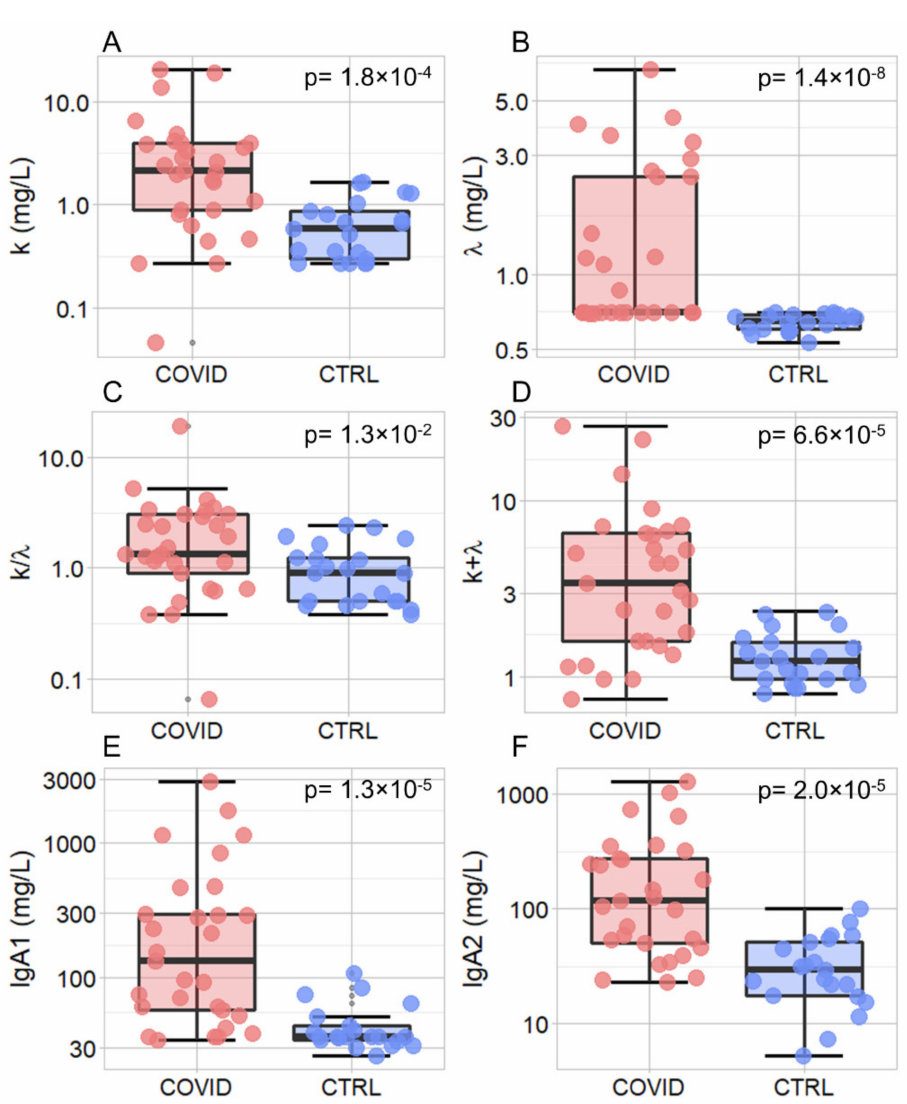
Figure 1. Box plot analysis of the salivary markers—k ( A ), λ ( B ), k/ λ ( C ), k+ λ ( D ), IgA1 ( E ) and IgA2 ( F )—measured in COVID-19 patients (light red) and control subjects (blue). Comparisons between the two groups were performed using the Wilcoxon Unpaired Two-Sample